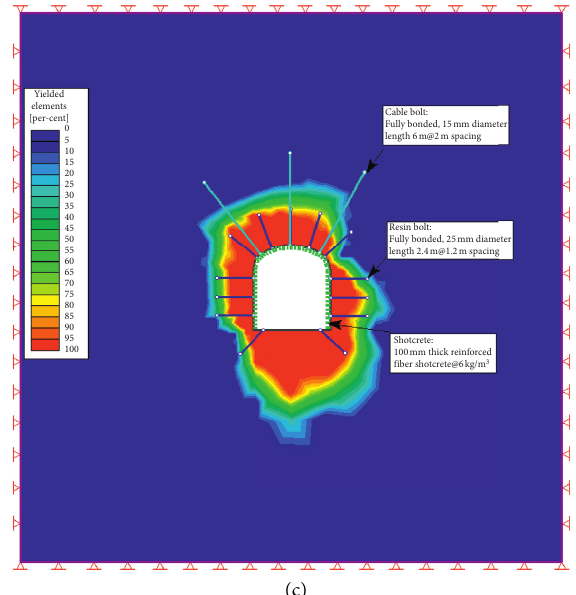
Figure 13: Simulation effect of the new support scheme. (a) The distribution of maximum principal stress. (b) The displacement of surrounding rock. (c) The distribution of rock mass yielding.